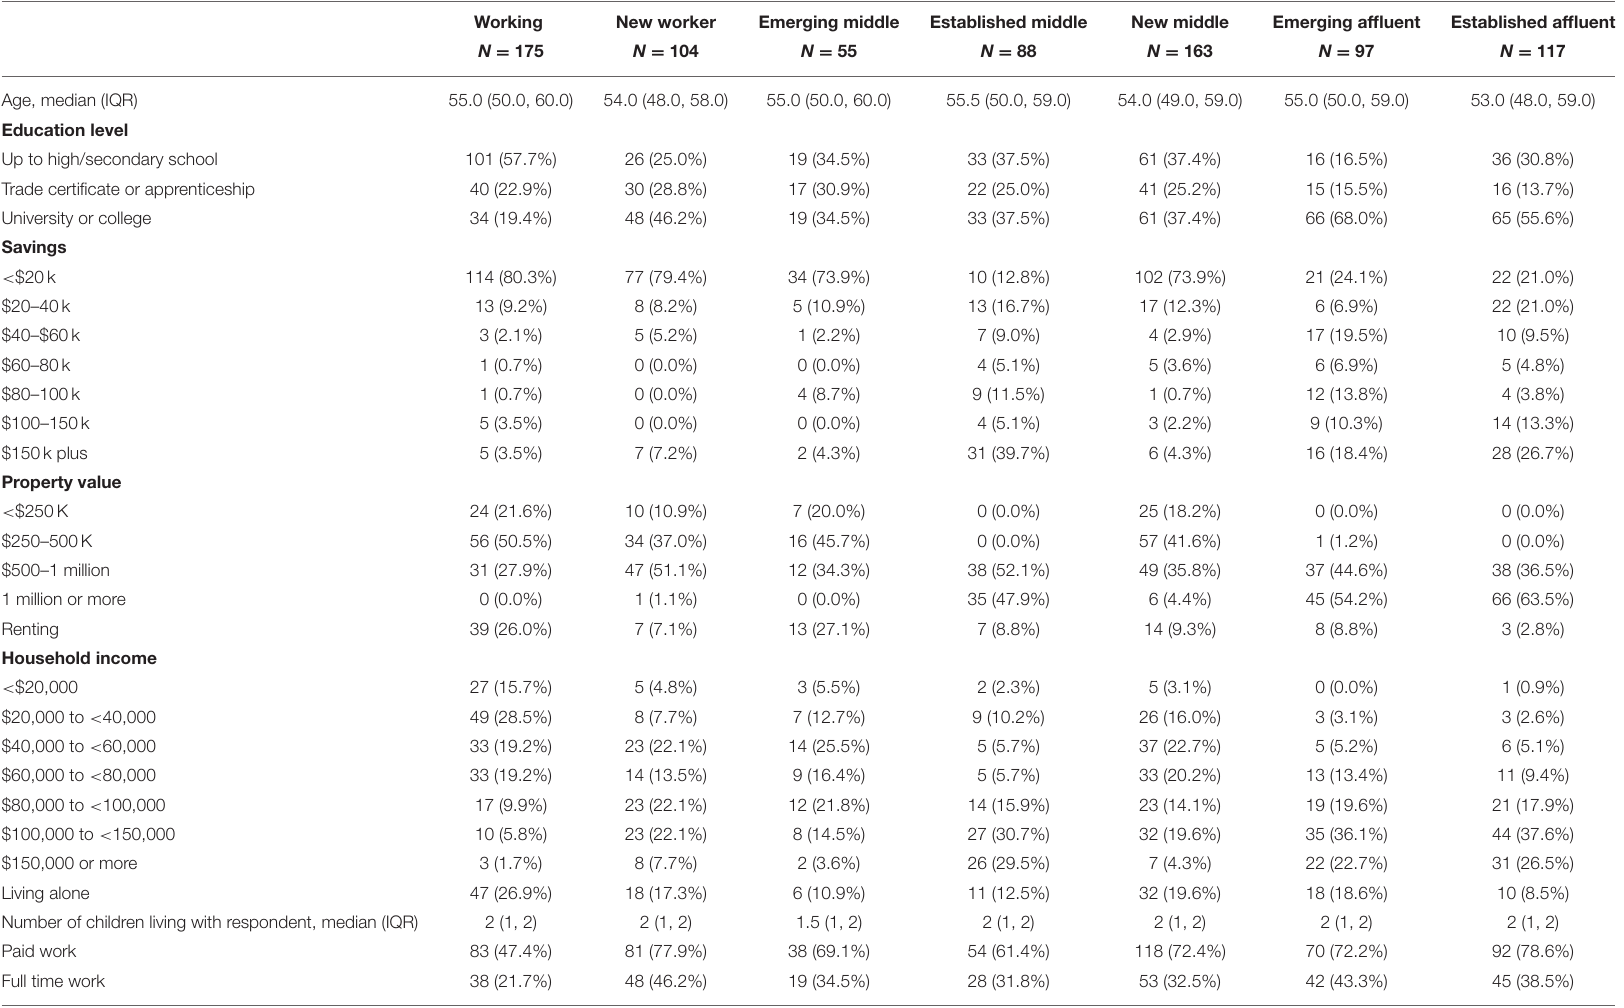
TABLE 3 | Respondent